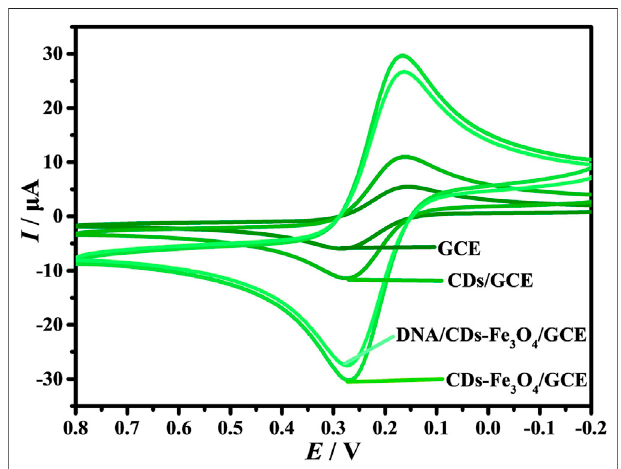
FIGURE 4 | (A) CVs of DNA/CDs-Fe 3 O 4 /GCE in1.0 mM [Fe(CN) 6 ] 3-/4- and 0.1 M KCl solution with different v (a – m: 0.01, 0.025, 0.05, 0.075, 0.1, 0.125, 0.15, 0.175, 0.20, 0.225, 0.25, 0,275, 0.3 Vs − 1 ). (B) The relationship of redox peak current ( I ) with v 1/2 .